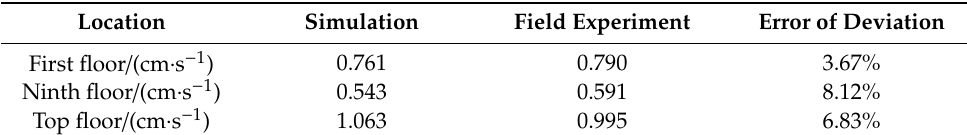
Table 9. Comparison of PPVs.